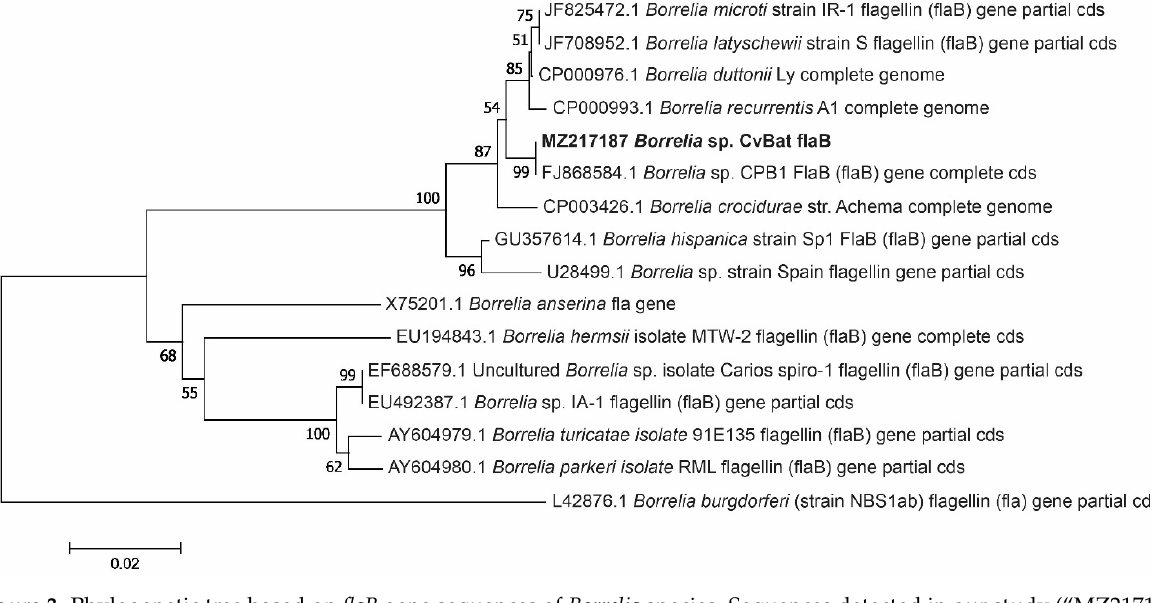
Figure 4. Phylogenetic tree based on 16S rRNA gene sequences of Borrelia species. Sequences detected in our study (‘‘MZ210080 Borrelia sp. CvBat 16S’’, n = 4) are highlighted in bold. Samples that resulted in a successful sequencing of the 16S-23S rRNA IGS had sig- nificantly lower Cq-values ( n = 11, median 25.9, IQR 23.4–29.4) in the real-time PCR assay compared to samples that failed to produce PCR products with the 16S-23S IGS assay ( n = 11, median 32.4, IQR 31.1–39.7, p = 0.003).